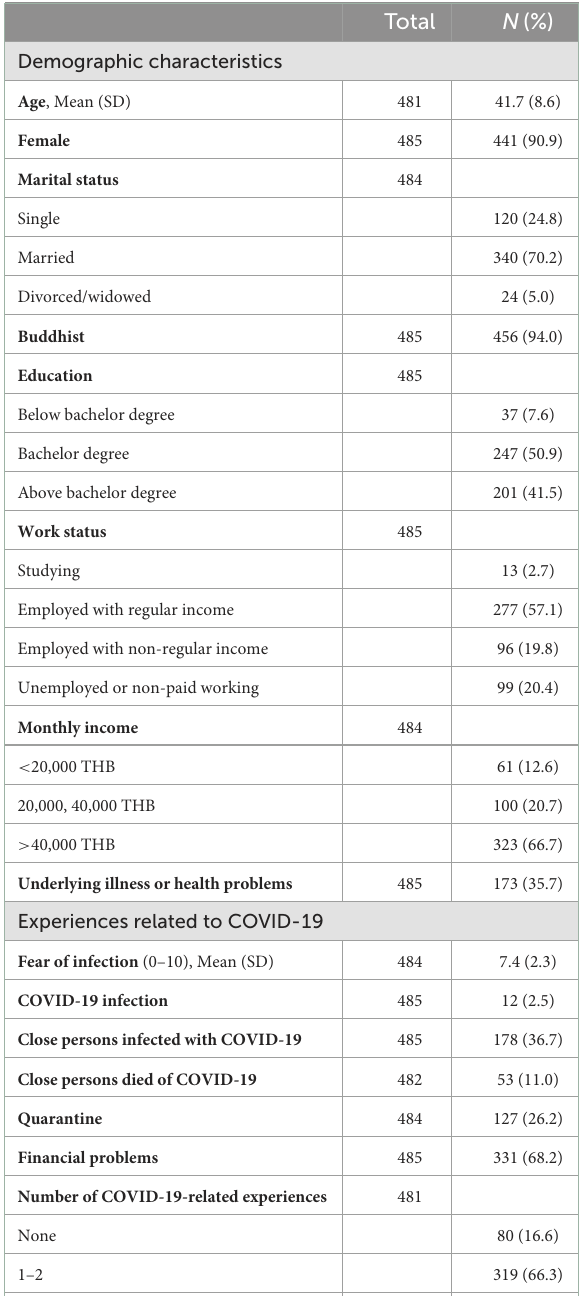
TABLE 1 Characteristics of the